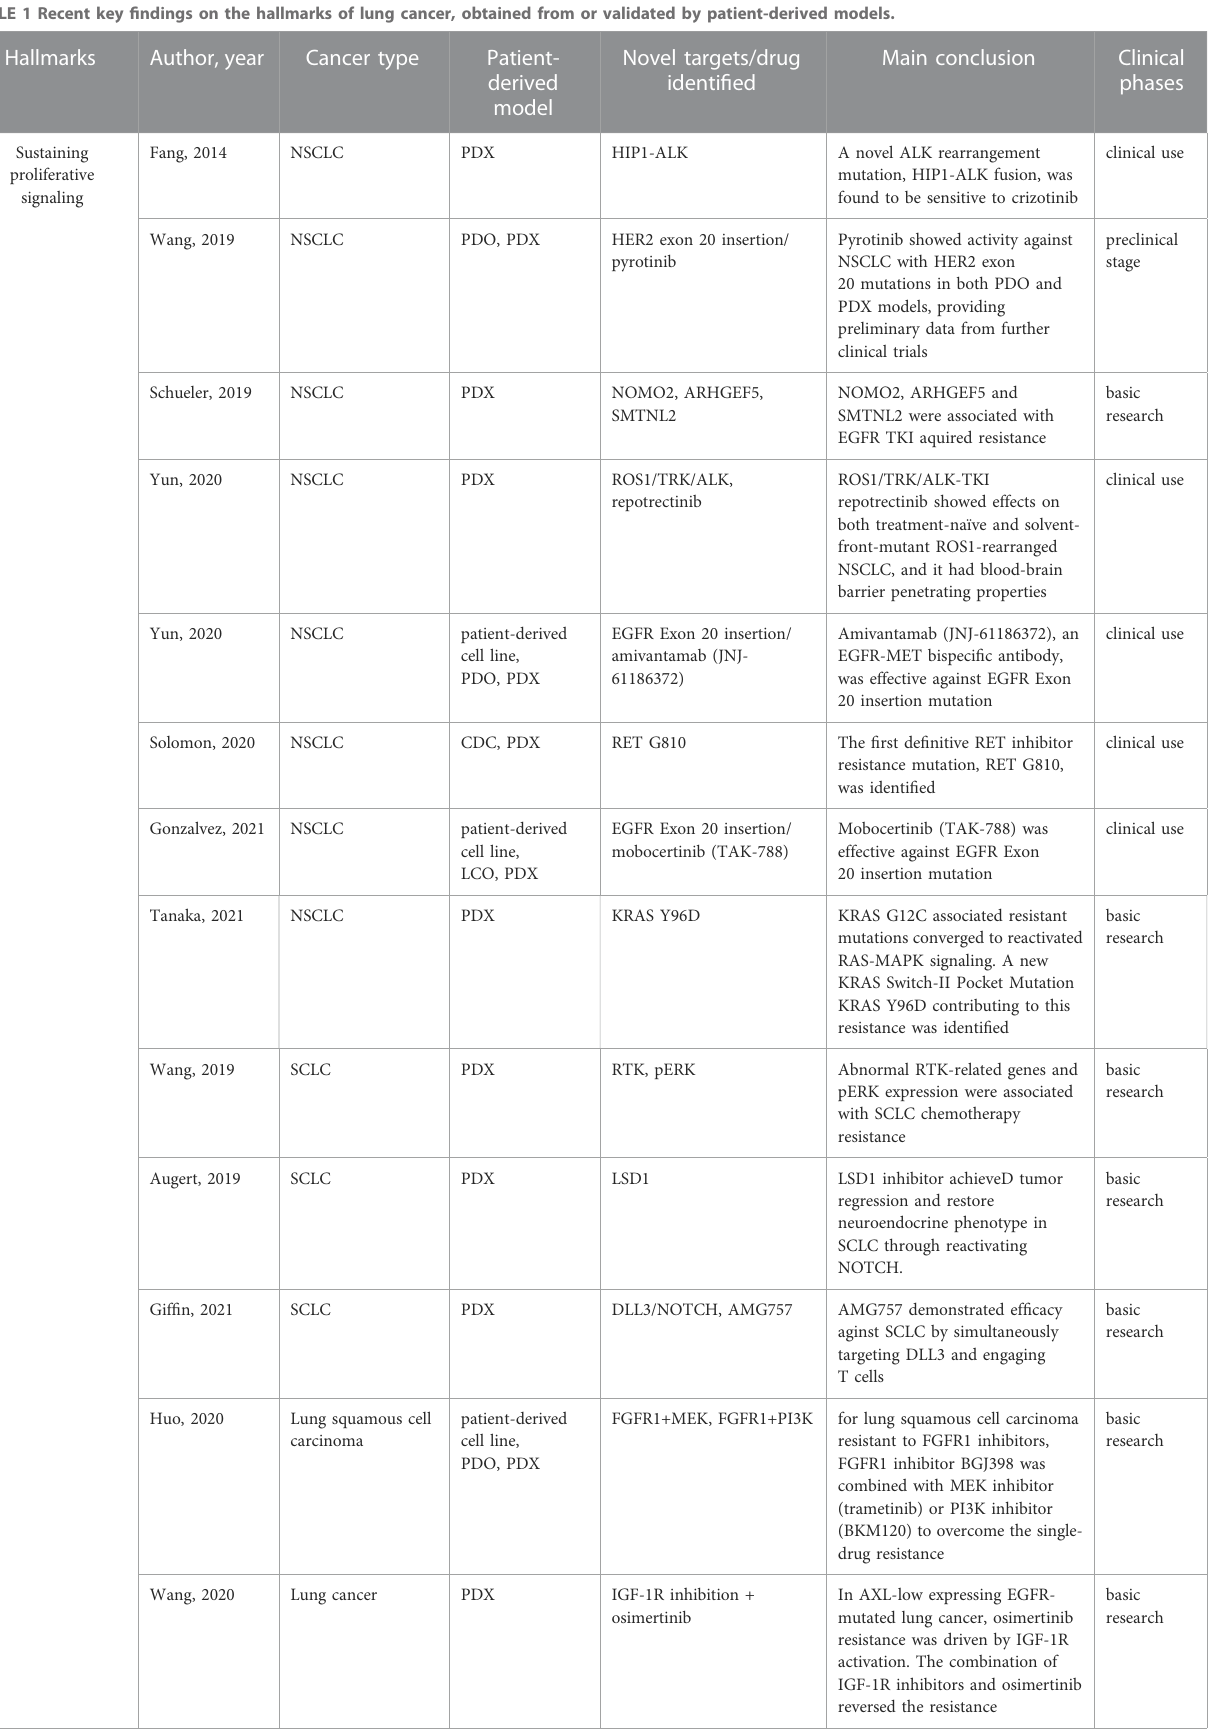
TABLE 1 Recent key fi ndings on the hallmarks of lung cancer, obtained from or validated by patient-derived models.